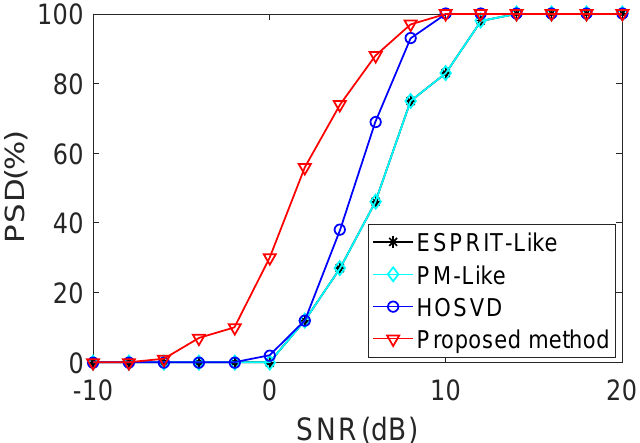
Figure 7. PSD performance comparison versus SNR with strong mutual